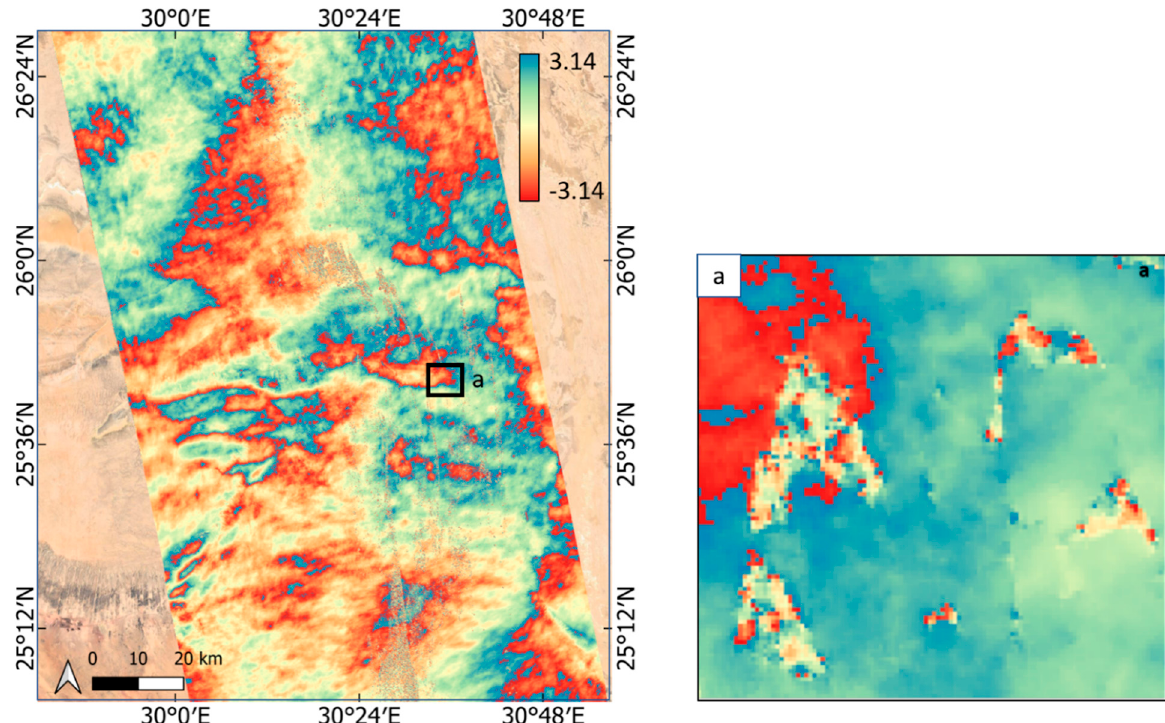
Figure 10. Detail of sub-areas a and b outlined in Figure 9 : optical high-resolution satellite images referred to the years 2013 and 2018, Mean Short-Term Coherence (MSTC) and Temporal Stability Index (TSI) maps. Images identify cultivated fields and sandy dune structures as very unstable areas.